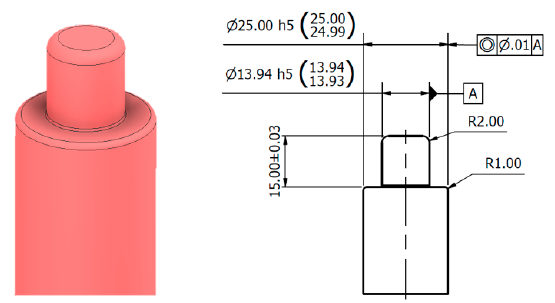
Figure 17. Design of calibration shaft according to measuring.